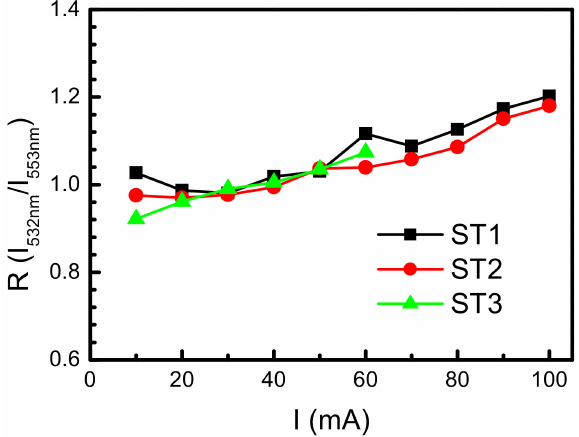
Figure 8. The electroluminescence intensity ratio R(I 532 nm /I 553 nm ) of samples ST1, ST2, and ST3 measured at room temperature with different injection current